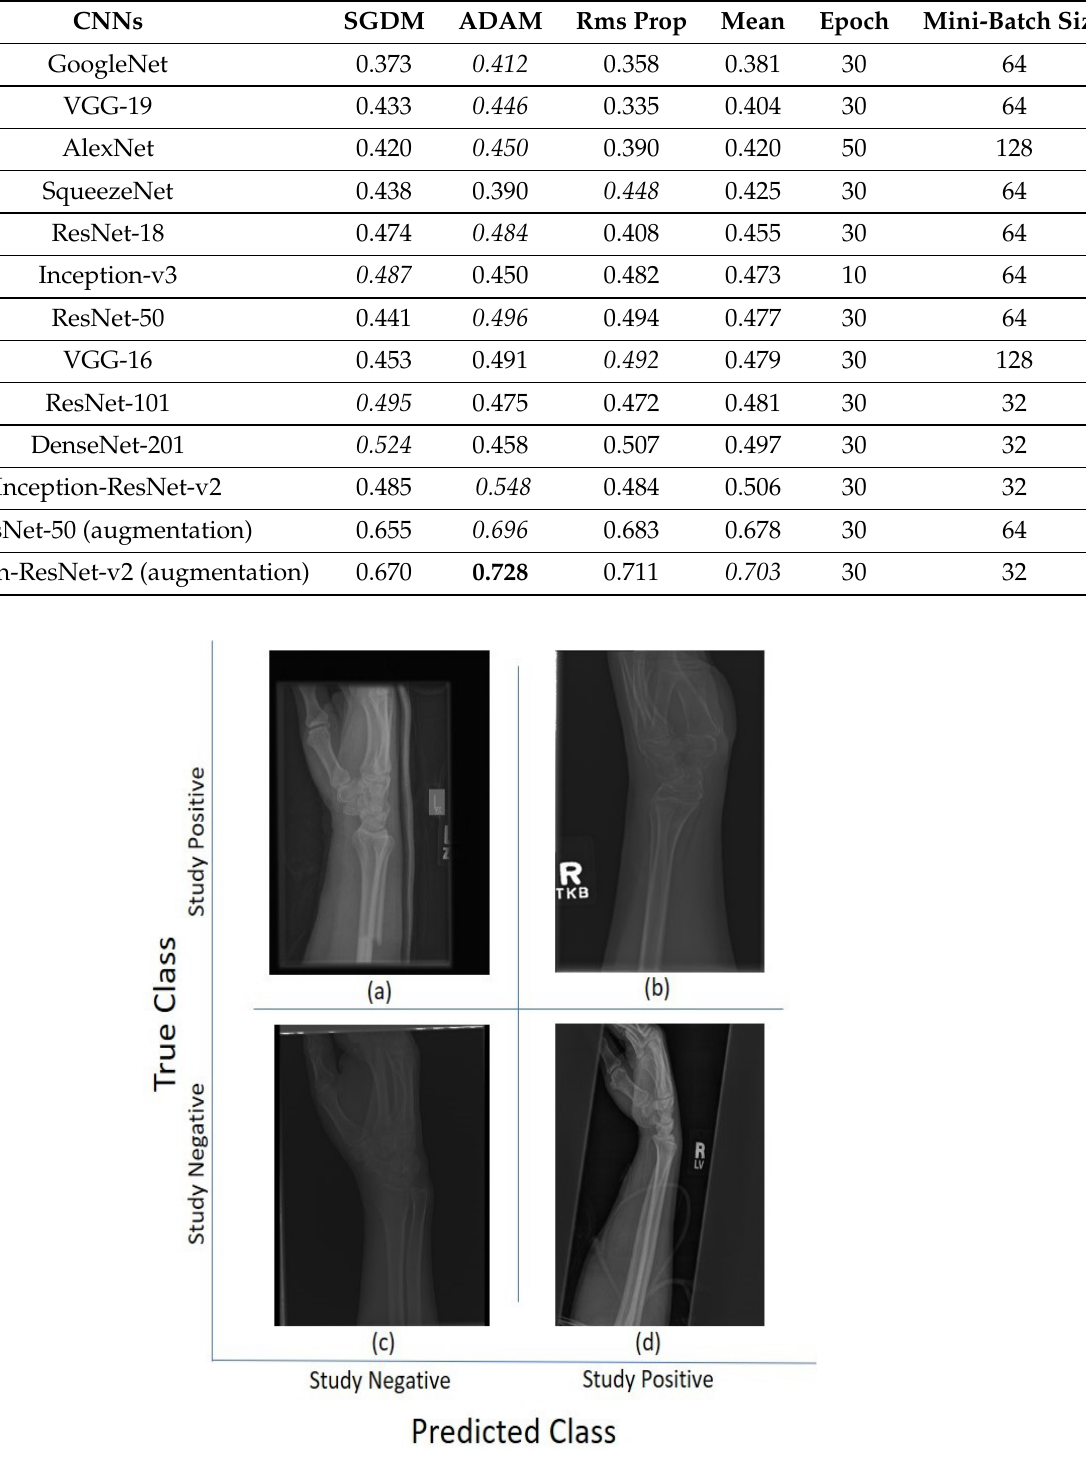
Figure 5. Illustration of classification results for lateral (LA) views of wrist radiographs. ( a ) Corre- sponds to positive (abnormal) diagnosis image but predicted as negative (normal), ( b ) Abnormal diagnosis and abnormal prediction. ( c ) Normal diagnosis image and normal prediction. ( d ) Normal diagnosis and abnormal prediction. Notice that the errors in classification may have been biased by artefact elements on the